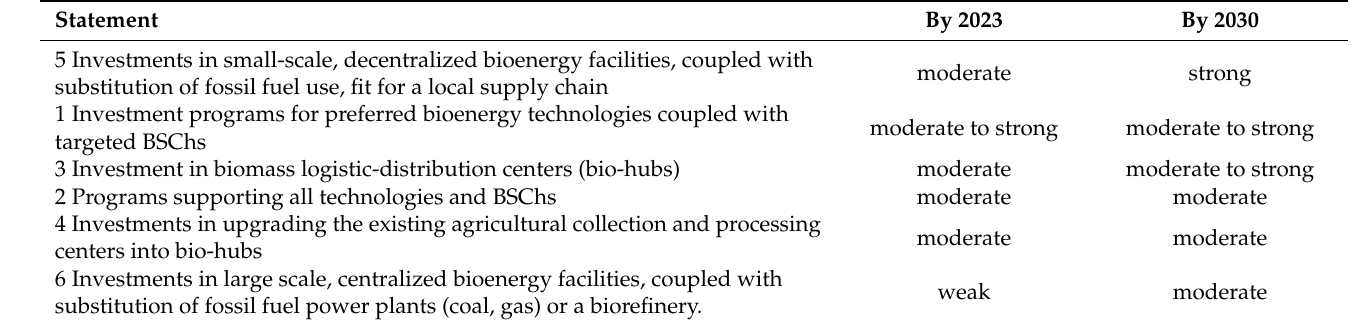
Table 7. Aggregated experts’ consensus on the impacts of the investments in infrastructure and technology to enhance BSChs to the economic growth, across different